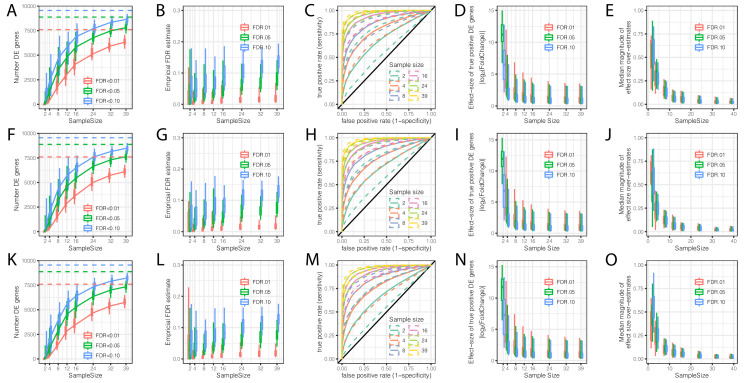
Evaluation of the contribution of sample size and read depth to differential expression analysis between chimpanzee and human.(A) The number of DE genes identified at varying thresholds after randomly subsampling (with replacement) the number of individuals in each species at the indicated sample size per species (hereafter referred to as a single bootstrap replicate). Dashed lines indicate the number of DE genes identified from the full dataset of 39 human and 39 chimpanzee individuals. Box-whisker plots depict quantiles among 100 bootstrap replicates. (B) An empirical estimate of FDR was obtained by calculating the fraction of DE genes in each subsample which were not identified at FDR < 0.01 in the full dataset. (C) Receiver operator characteristic (ROC) curves indicate the sensitivity and specificity of DE gene classification at varying significance thresholds. For each sample size, the filled line represents the median ROC sensitivity amongst 100 bootstrap replicates, while the dashed lines represent the 0.05 and 0.95 quantiles. (D) The ability to significantly detect small effect size DE genes increases as sample size increases. At each indicated subsample size, box-whisker plot indicates effect size of true significant DE genes (The effect size and true classifications of significant DE genes are defined as those at FDR < 0.01 with the full dataset). (E) Winner’s curse effects decrease with increasing sample size. The distribution of median differences between the estimated effect size of DE genes and the true effect sizes estimated from the full dataset among 100 bootstrap replicates. (F–L) Same as (A–E) but each sample was subsampled at the level of RNA-seq reads to a depth of 25 million mapped reads. (K–O) Same as (A–E) but each sample was subsampled to 10 million mapped reads. All box-whisker plots depict 0.05, 0.25, 0.5, 0.75, and 0.95 quantiles among 100 bootstrap replicates.